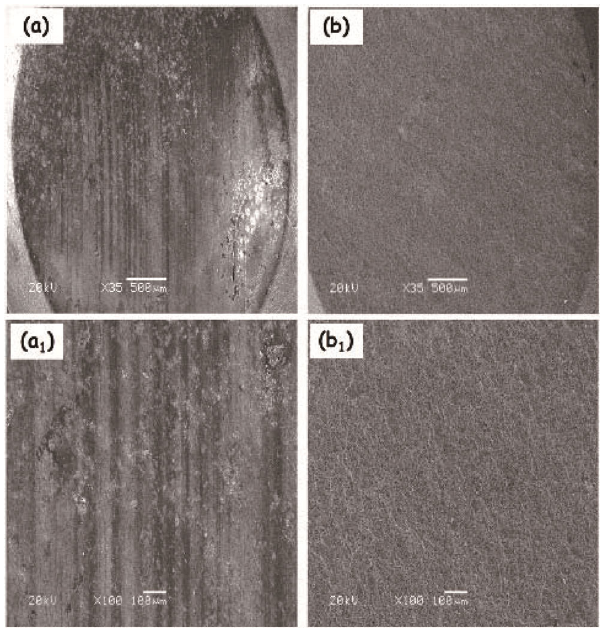
Fig. 10 SEM images and enlarged views showing the morphologies of alumina counterface after sliding against (a, a 1 ) AISI 1045 and (b, b 1 ) AISI 2205